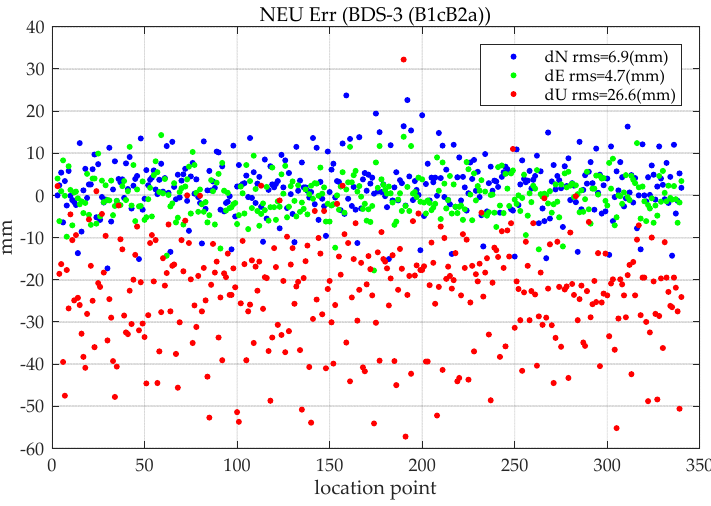
Figure 6. Static BDS-3 (B1cB2a) PPP positioning error. Table 3. Static PPP positioning accuracy and average RMS value statistics.